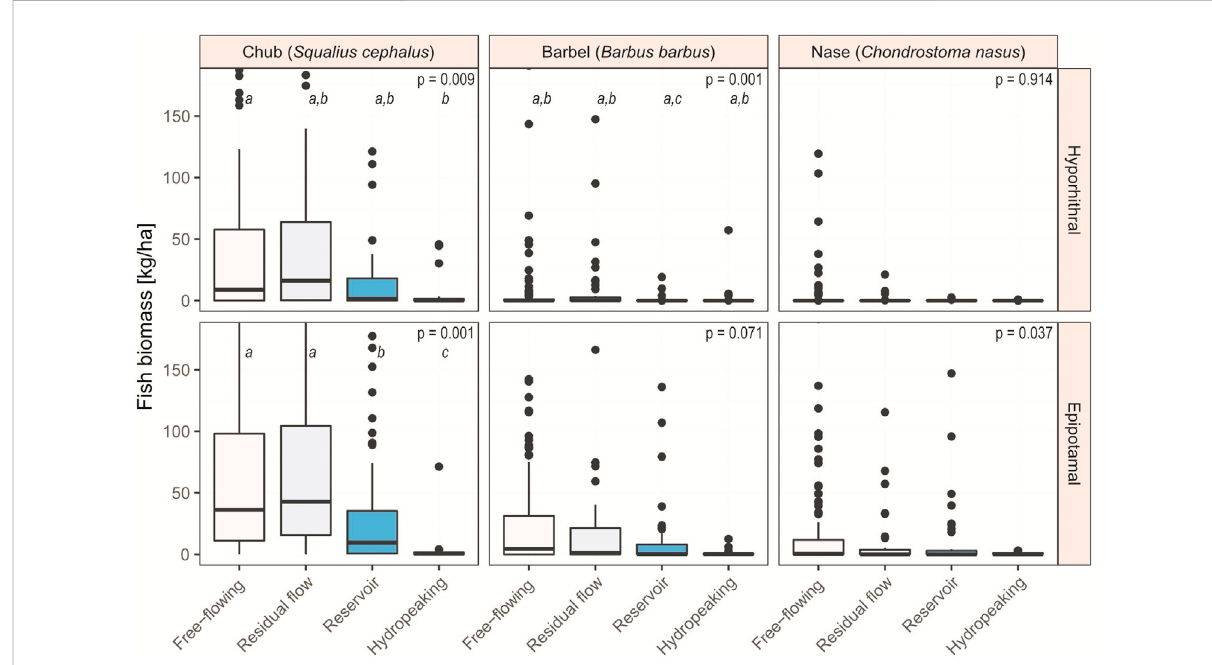
FIGURE 5 Biomassofthethreetargetspeciesinthehyporhithralandepipotamal fi shregion(graylingandbarbelzone),separatedbyhydro-morphological impact type. Outliers and data points > 180 kg/ha have been graphically cut off for better readability (chub: n = 55, max = 1,107 kg/ha; barbel: n = 10, max = 682 kg/ha; nase: n = 9, max = 1,076 kg/ha). This dataset includes only river sections where the respective target species is classi fi ed as ‘ dominant ’ or ‘ subdominant ’ according to the Austrian Leitbild classi fi cation (BAW, 2007). The same letters above the boxplots indicate that the categories are considered equal, different letters indicate a signi fi cant